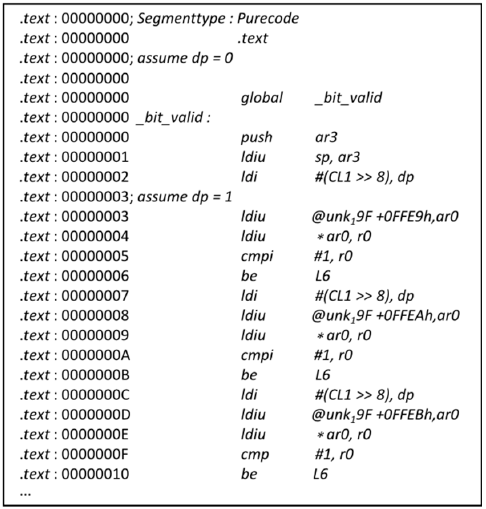
Figure 9. Assembly instructions.